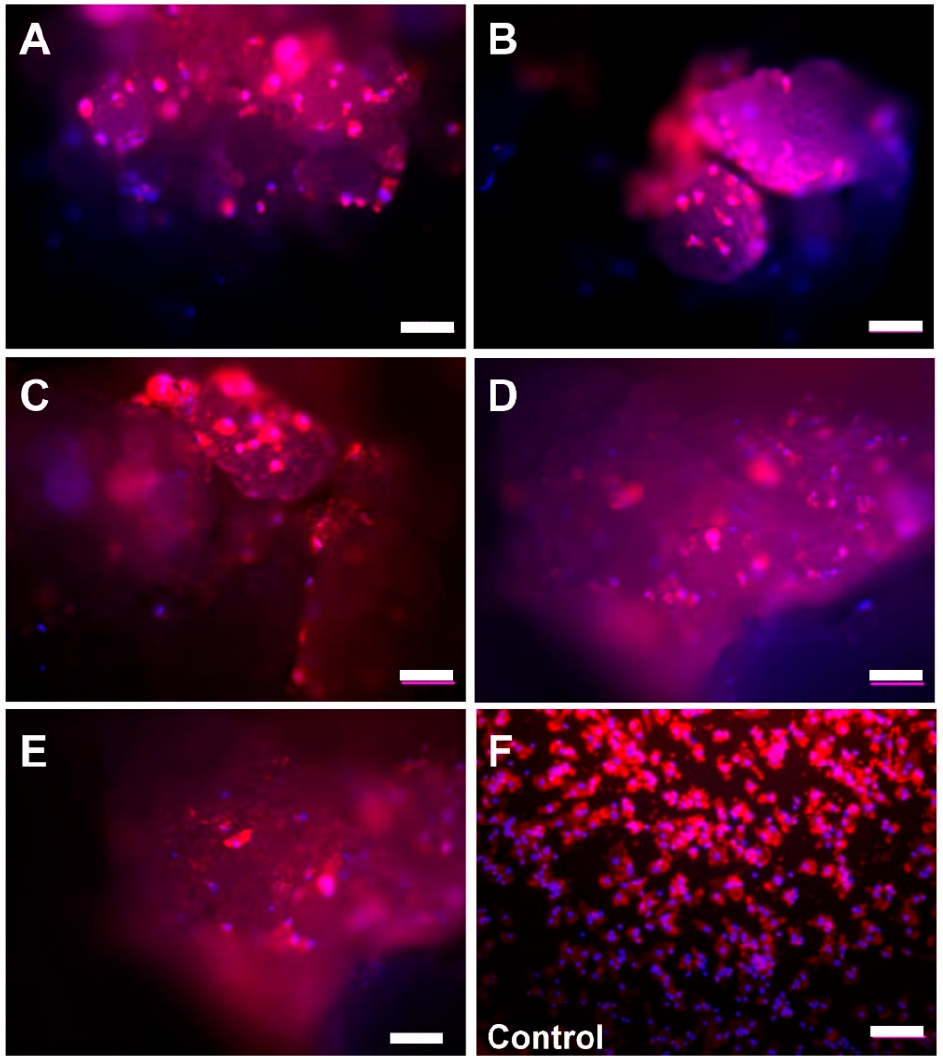
Figure 2. Microscopic images of the primary monocytes/macrophages on the surfaces of the five bone substitute materials ( A : Cerasorb 50–150 µ m, B : Cerasorb 63–250 µ m, C : Cerasorb M 150–500 µ m, D : Cerasorb M 500–1000 µ m, E : Cerasorb 500–1000 µ m) and of the control group ( F ) at day 1 In the control group (without bone substitute) most of the cells exhibited a macrophage- like cell structure (Figure 3F). Furthermore, some single multinucleated cells were de- tectable within the control